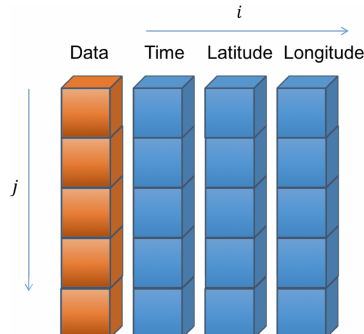
Figure A2. A list of data. Such a list is the primary data format used for the observations in this paper. Note that data may refer to any combination of observations, e.g. AOD at multiple wavelengths or AOD and AAOD at 550nm. However, the dataset is homogenous. Reproduced from Watson-Parris et al.